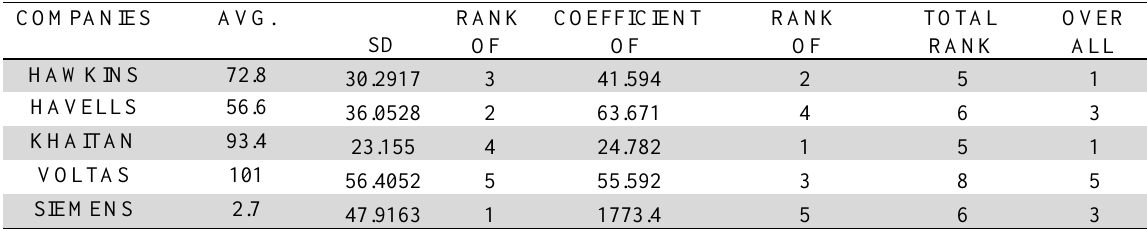
Ranking on the basis of Average and Consistency of Cash conversion Cycle of the Selected Companies of Consumer Durable